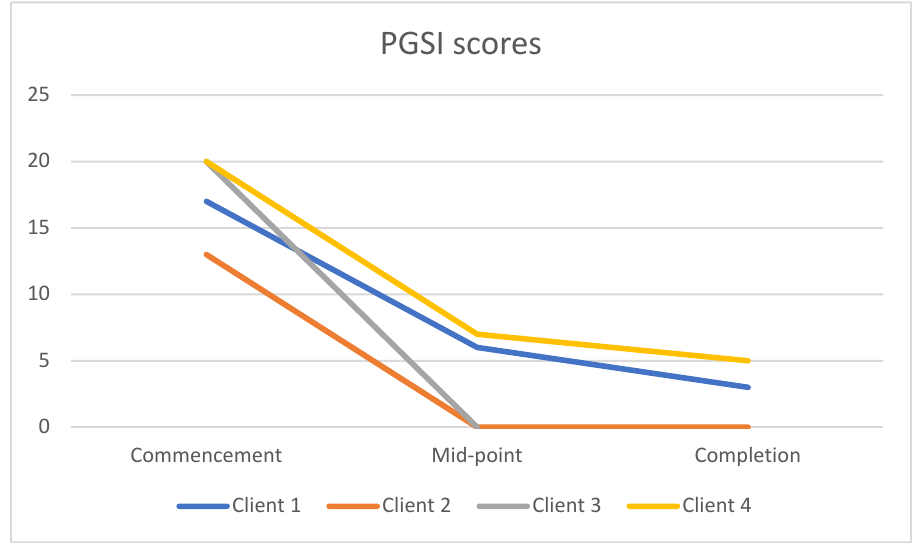
Figure 1. Change in Problem Gambling Severity Index (PGSI) scores during treatment. Table 1. PGSI paired samples test—Commencement to Completion.